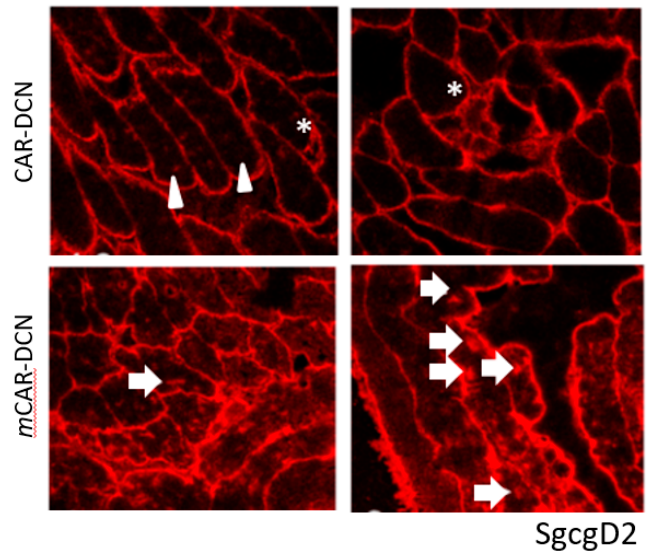
Figure 5. Three-weeks of CAR-DCN treatment decreased p-SMAD2/3 staining in the SgcgD2 mouse model. p-SMAD2/3 specific antibodies followed by species specific secondary antibody were used to detect nuclear and therefore activated p-SMAD2/3. Although these animals were not injected with EBD (to reserve the robust red channel for low-abundance p-SMAD staining), the damaged fibers can be identified because of the variable fiber size (*) and central nuclei (arrowheads). All panels are from SgcgD2 quadriceps injected with either CAR-DCN or m CAR-DCN. Original magnification 40×.